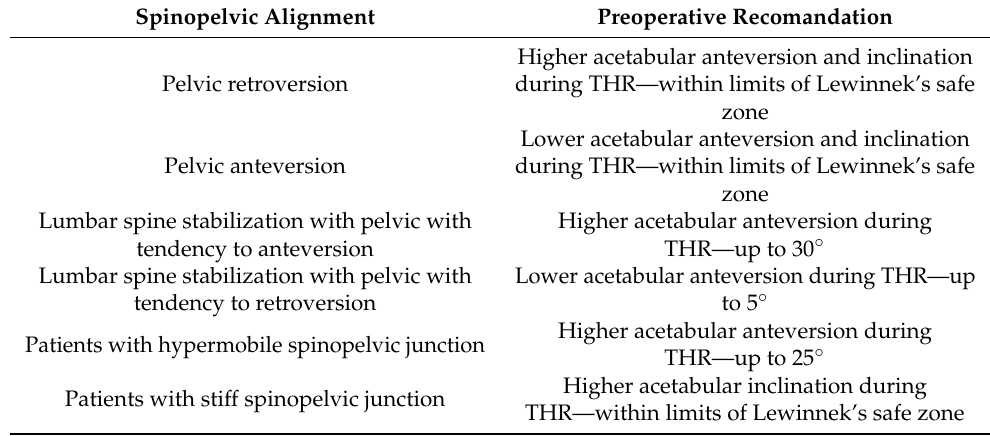
Table 3. Recommendation during THR (total hip replacement) in connection to spinopelvic alignment. Spinopelvic Alignment Preoperative Recomandation Higher acetabular anteversion and inclination Pelvic retroversion during THR—within limits of Lewinnek’s safe zone Lower acetabular anteversion and inclination during THR—within limits of Lewinnek’s safe Pelvic anteversion zone Lumbar spine stabilization with pelvic with Higher acetabular anteversion during tendency to anteversion THR—up to 30 ◦ Lumbar spine stabilization with pelvic with Lower acetabular anteversion during THR—up tendency to retroversion to 5 ◦ Higher acetabular anteversion during Patients with hypermobile spinopelvic junction THR—up to 25 ◦ Higher acetabular inclination during Patients with stiff spinopelvic junction THR—within limits of Lewinnek’s safe